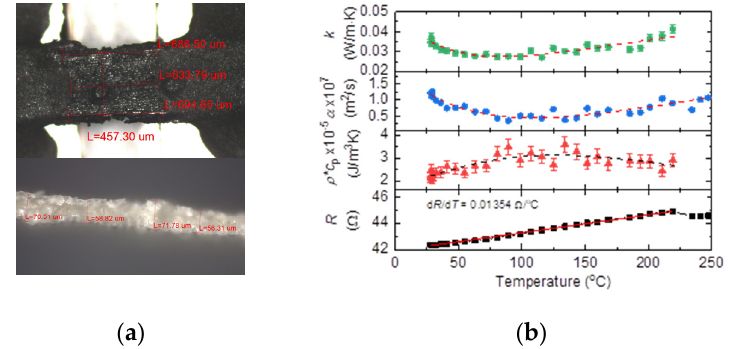
Figure 4. Continuous thermal characterization of corn leaves. ( a ) Length (top), width (top), and thickness (bottom) of the corn leaf sample with Ir coating. ( b ) The variations of thermal diffusivity α , thermal conductivity k , volumetric heat capacity ρ ∙ c p , and electric resistance R for the corn leaf sample against temperature. The dash lines show the varying of the properties.